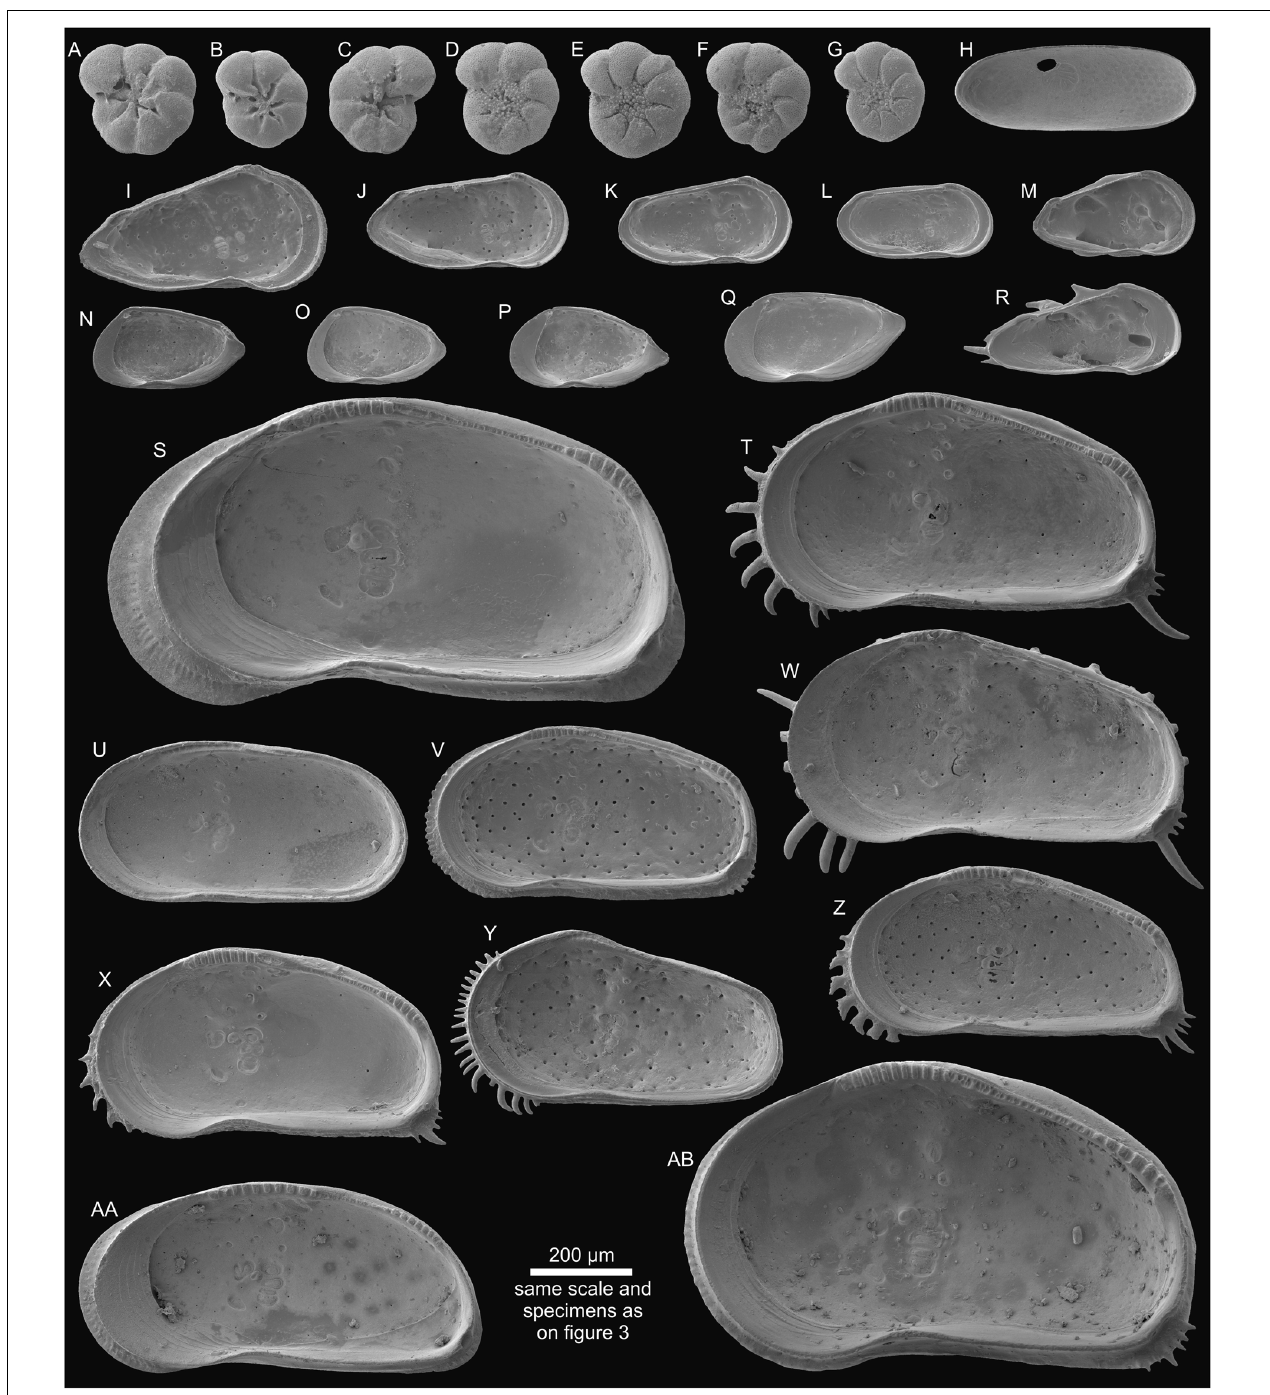
FIGURE 4 | Foraminifers and ostracods from Porvenir (sample PO-N-8; same specimens as in Figure 3 ). (A–C) Tests in umbilical view. (D–G) Tests in side view. (H–AB) Valves in internal view.